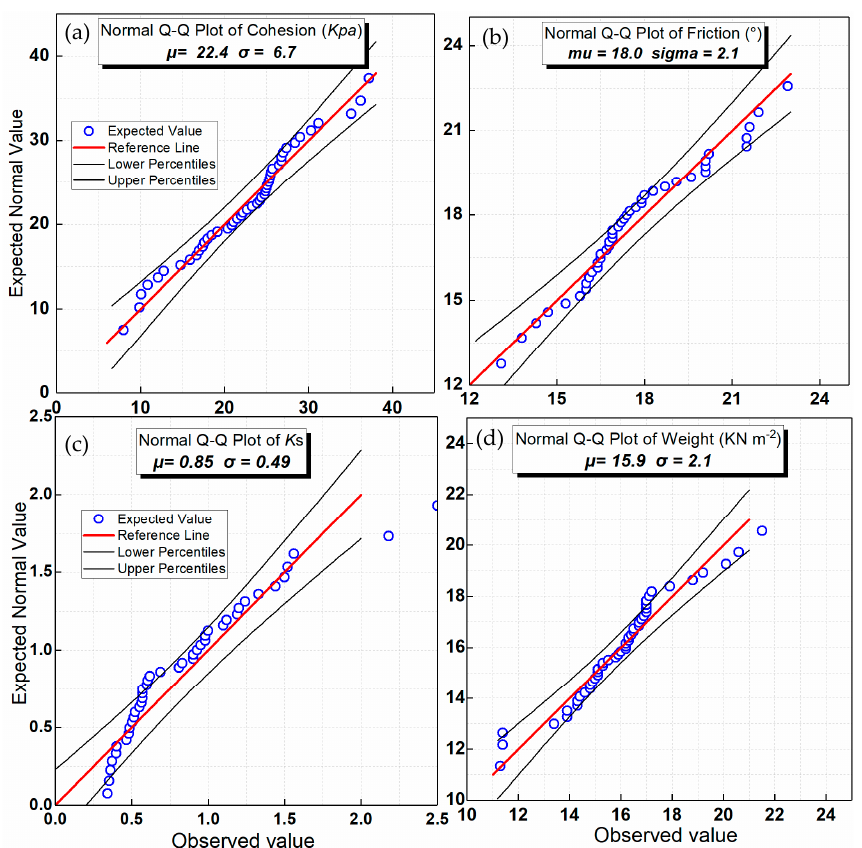
Figure 8. Quantile–quantile plots comparing the different input parameters to the normal distribution. The quantiles of each parameter are plotted against the quantiles of a standard normal distribution. The points will plot on a straight line if the two distributions are similar. ( a ) Cohesion. ( b ) Friction angle. ( c ) Saturated hydraulic conductivity (Ks). ( d ) Unit weight.